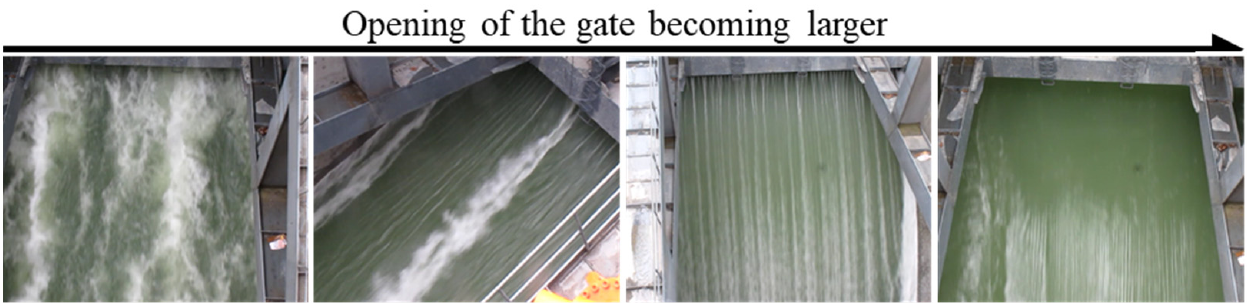
( d ) Figure 5. Water velocity and air volume fraction on the center line of typical sections (50% gate opening ratio) ( a ) downstream the gate, section marked 0 + 773.1 m; ( b ) downstream the aerator no. 2, section marked 1 + 141.90 m; ( c ) downstream the aerator no. 3, section marked 1 + 221.87 m; ( d ) downstream the aerator no. 4, section marked 1 + 360.52 m. 3.1.4. Improvement of the Drag Model